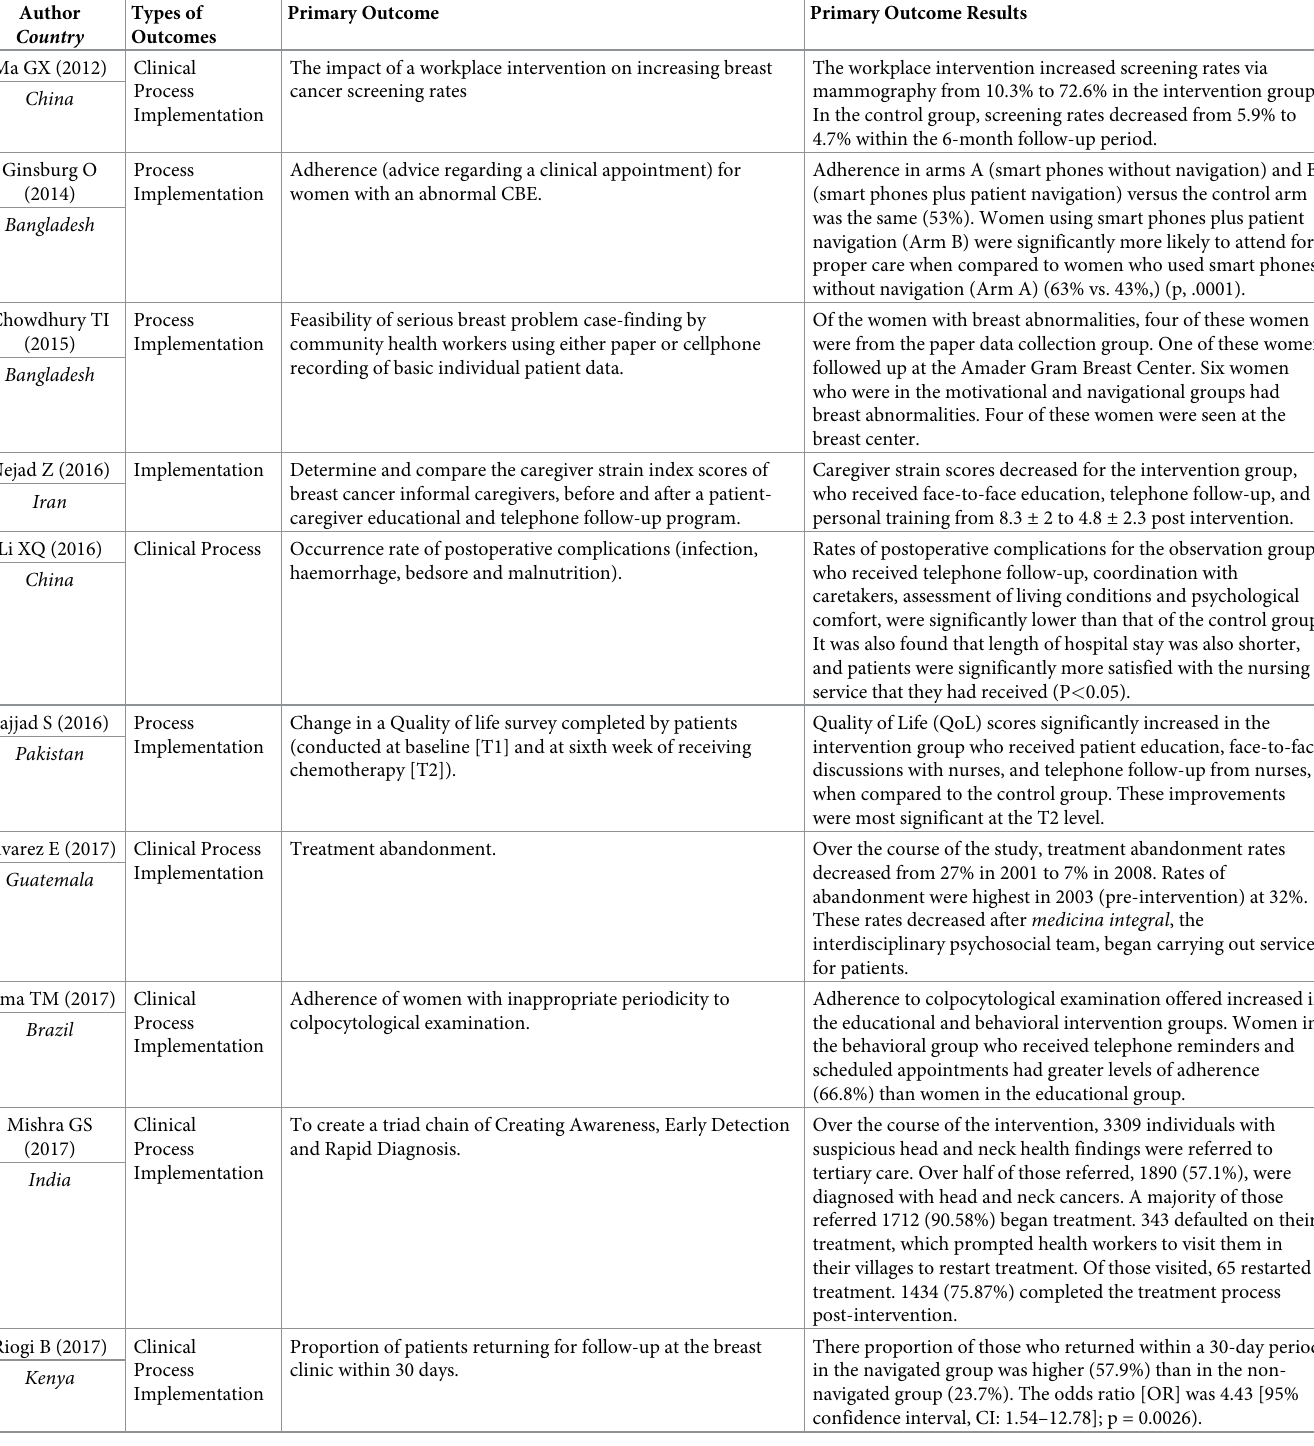
Table 4. Description of